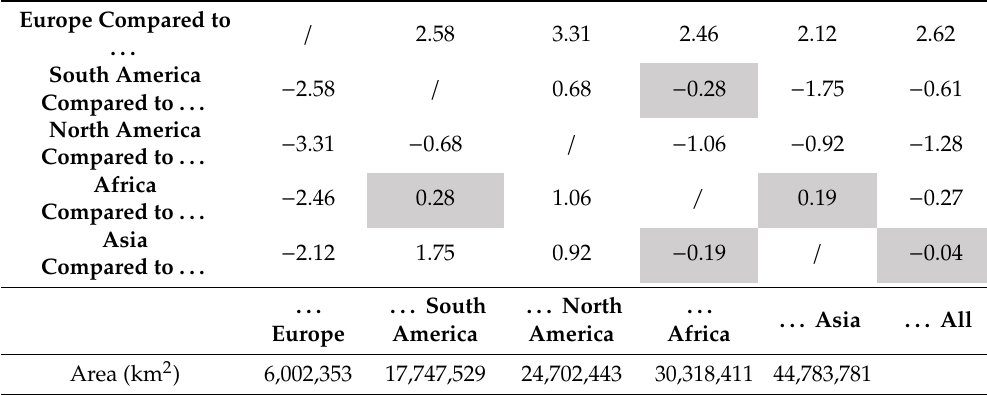
Table 9. Average relative estimated accuracy values for each continent (Gall–Peters projection), in positive values are overestimations, negative values are underestimations, in grey: more accurate values compared to the Mercator projection (Table 8). Europe Compared to . .